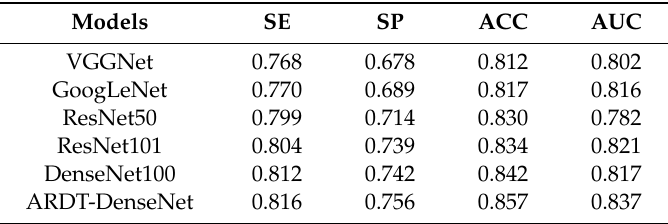
Table 4. Comparison of baseline models on ISIC 2016.